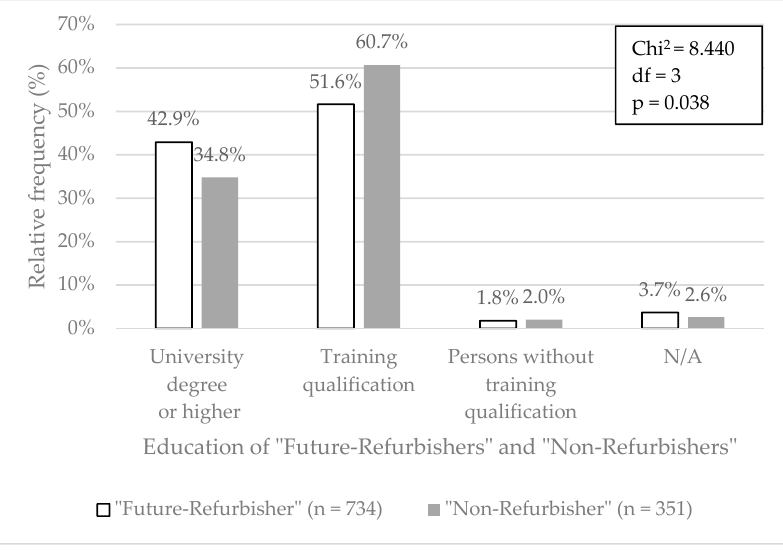
Figure 3. Average monthly net household income (in €) for “Future-Refurbishers” and “Non- Refurbishers”.